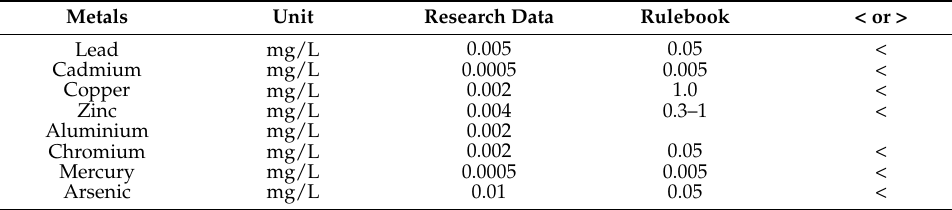
Table 9. Comparison research data with Rulebook) water quality criteria